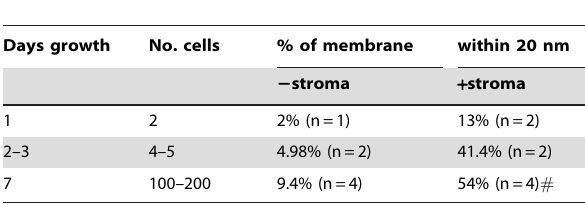
Table 1. Percentage of lateral membranes within 20 nm.